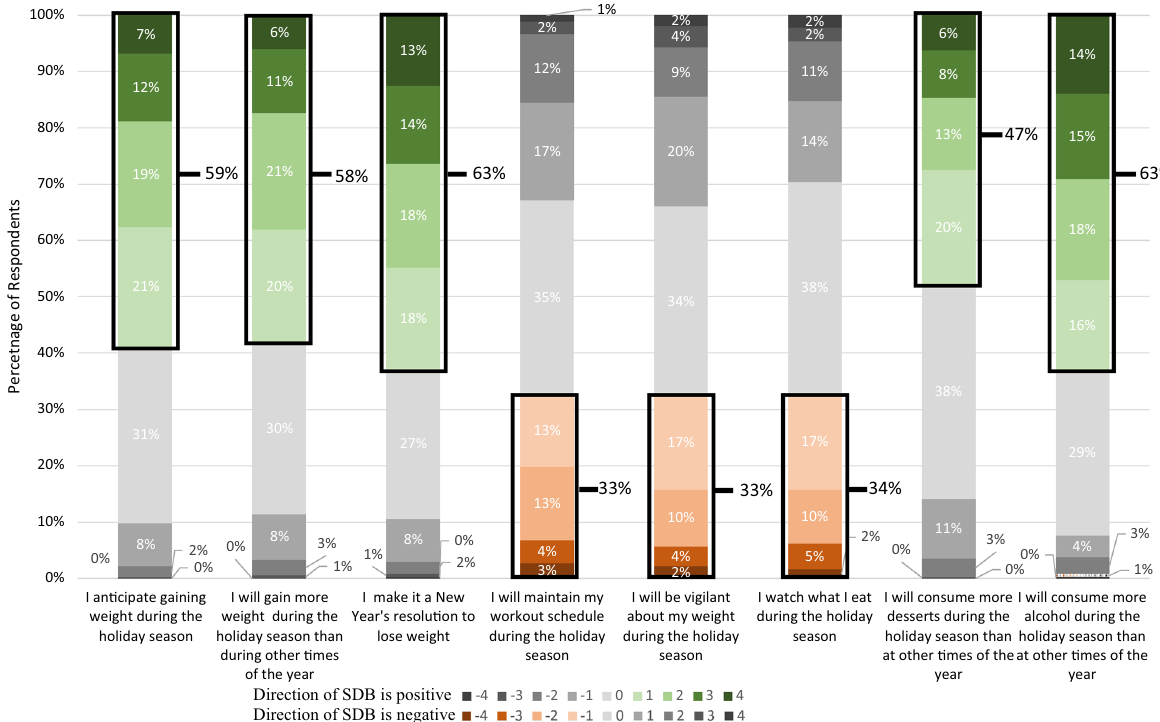
Fig. 1 Holiday SDB cheap talk sample n = 368. Exhibits SDB is de fi ned as having a score of less than − 1 or >1, depending on the statement. Black boxes indicate the direction of SDB, therefore the percentage of respondents who indicated SDB can be determined by adding the percentages within the box for that question. For example for the statement “ I anticipate gaining weight during the holiday season ” , the percentage who exhibit SDB can be calculated by adding 7 + 12 + 19 + 21 = 59, and is given to the right of the